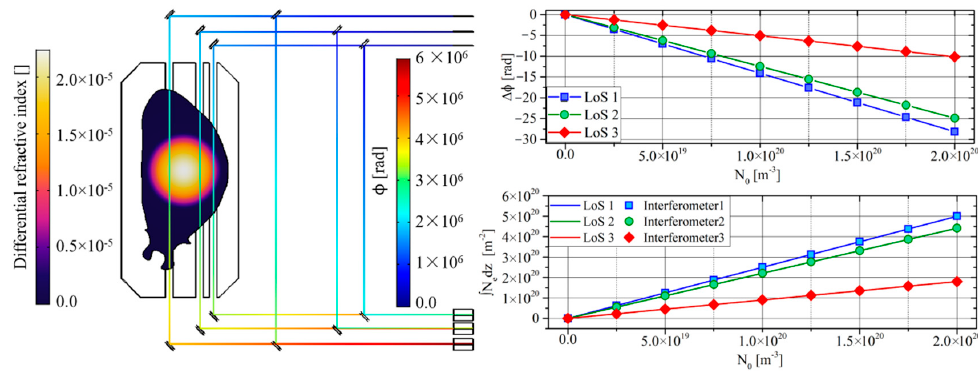
Figure 4. Interferometer